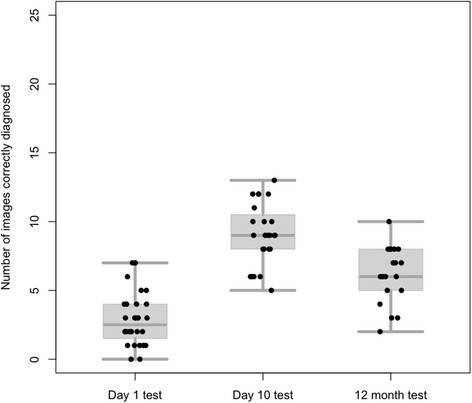
Combined box-plots and scatter plots showing all the test scores for the 30 students randomly recalled for re-testing after 12 months. Day 1 test (n=28, median=2.5), Day 10 test (n=24, median=9) and 12 Month test (n=19, median=6).